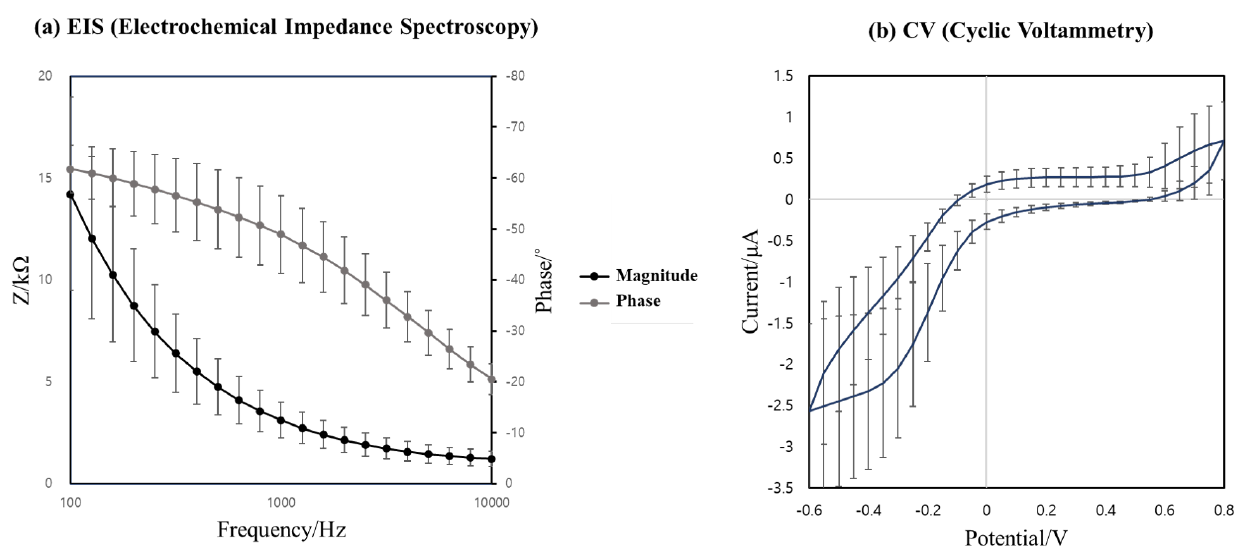
Figure 5. Electrochemical properties of the manufactured 32-channel cochlear electrode array: ( a ) Electrochemical impedance spectroscopy in a frequency range of 100 Hz–10 kHz: average impedance magnitude (black) and average phase angle (gray); and ( b ) cyclic voltammetry of the electrodes was measured within a voltage range of − 0.6 V to 0.8 V versus the Ag/AgCl reference electrode.